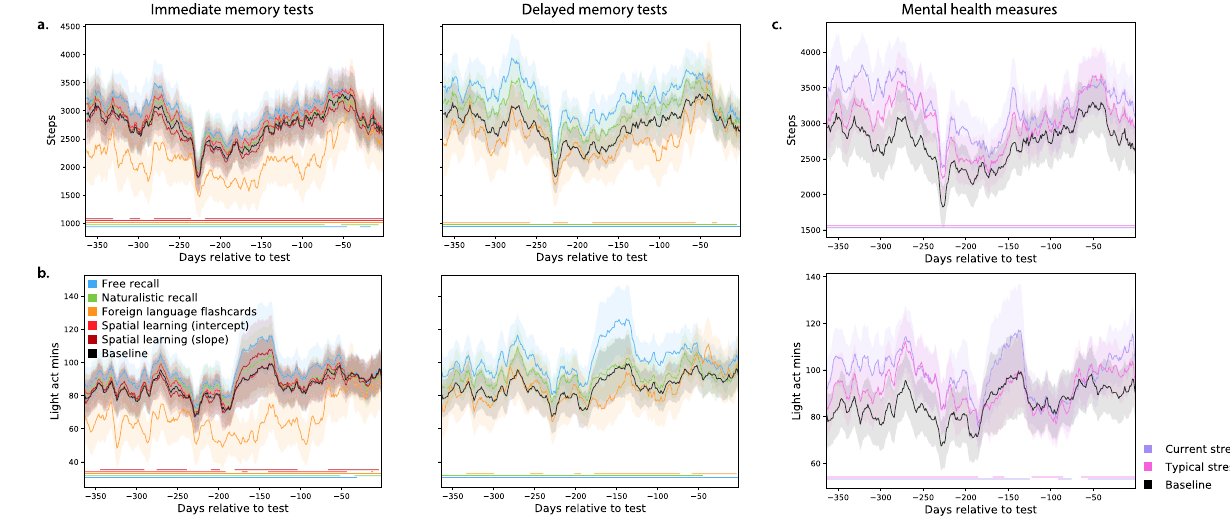
Figure 6. Dynamics of physical activity vary with memory performance and mental health measures. ( a ) Daily step counts. Each timecourse is weighted by either performance on immediate recall tests (left panel) or on delayed recall tests (right panel). The black (baseline) timecourses display the (unweighted) average across all participants. ( b ) Daily duration (in minutes) of low-intensity physical activity. Timecourses are displayed in the same format and color scheme as those in panel a . Analogous timecourses for additional fitness-related measures may be found in Figs. S15, S16, and S17. ( c ) Timecourses of physical activity, weighted by mental health measures. The timecourses in each panel display the average daily step counts (top panel) or duration of low-intensity activity (bottom panel). The colored lines show average activity dynamics weighted by self- reported stress levels at the start of the experiment (purple) and self-reported “typical” stress levels (pink). The baseline curves (black) display the average across all participants (re-plotted in panel c to illustrate scale differences across panels). Timecourses for additional mental health-related and fitness-related measures may be found in Figs. S18, S19, and S20. Error ribbons in all panels denote the standard error of the mean. Horizontal lines below each panel’s timecourses denote intervals over which each weighted measure (color) differs from the unweighted baseline (via a paired sample two-sided t -test of the weighted mean values for each measure within a 30-day window around each timepoint; horizontal lines denote p < 0.05 ,